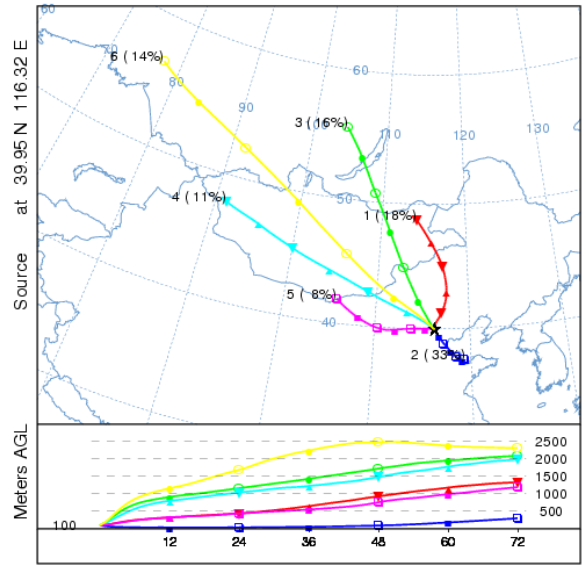
Fig. 6. 72-h backward trajectories for 100 m above ground level at Beijing urban site during July 2009 to June 2010. most important for the Beijing urban site, contributing 33 % of air